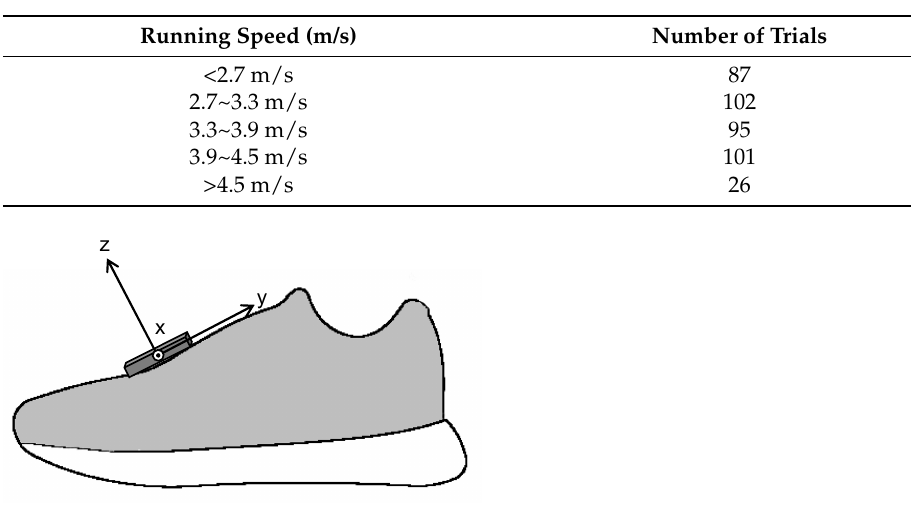
Table 2. Running speeds and number of collected trials.